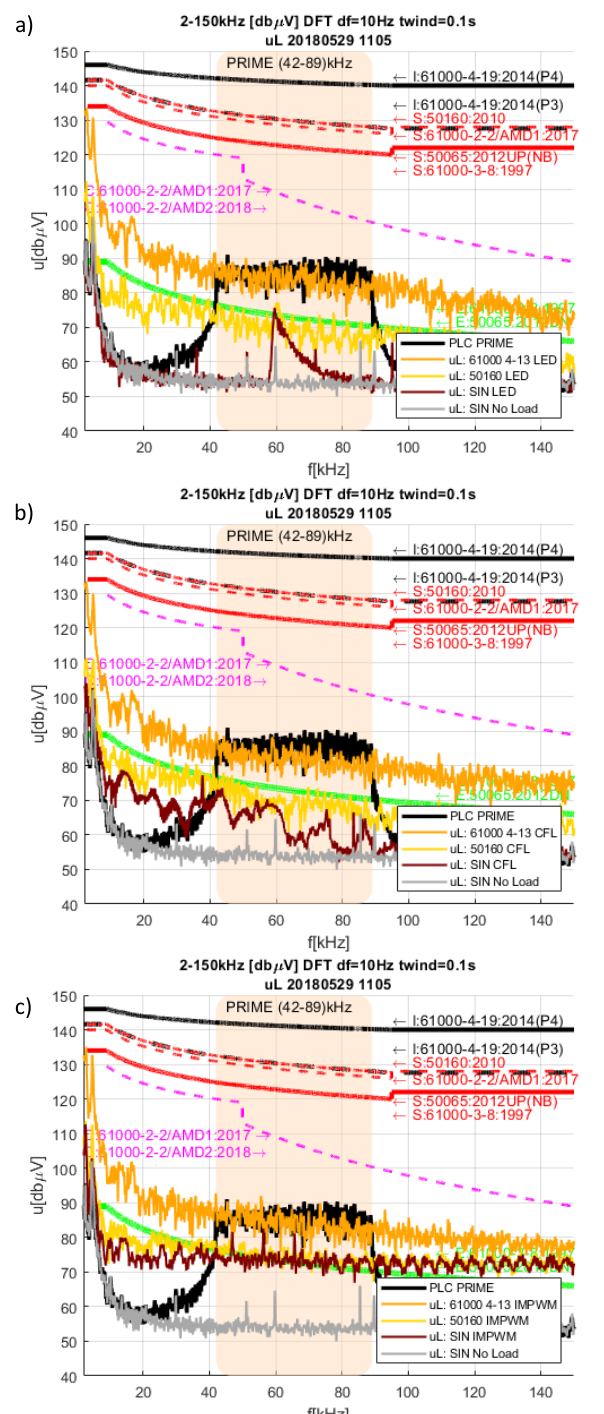
Figure 11. Summary: spectra of the voltage in the connection point of the load and energy meter for mixture cases representing results of the analysis of PRIME PLC system operation with ( a ) LED; ( b ) CFL; and ( c ) induction motor with PWM converter; under the different contribution of low-frequency distortion in the supply voltage (pure sinusoid (brown), EN 50160:2015 [3] (yellow), IEC 61000-4-13 [30] (orange)) with relation to no-load condition (grey) and PRIME transmission (black) (uL—line voltage in the point of the equipment connection, which is also the point of energy meter connection with PRIME PLC).